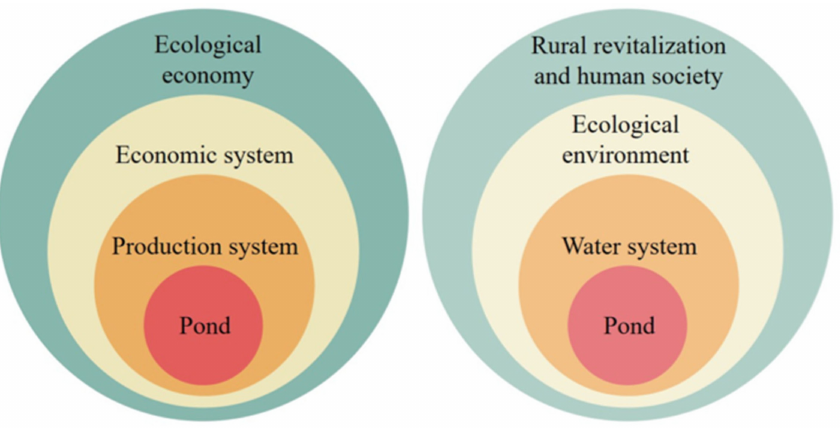
Figure 4. Two development approaches for the pond-based